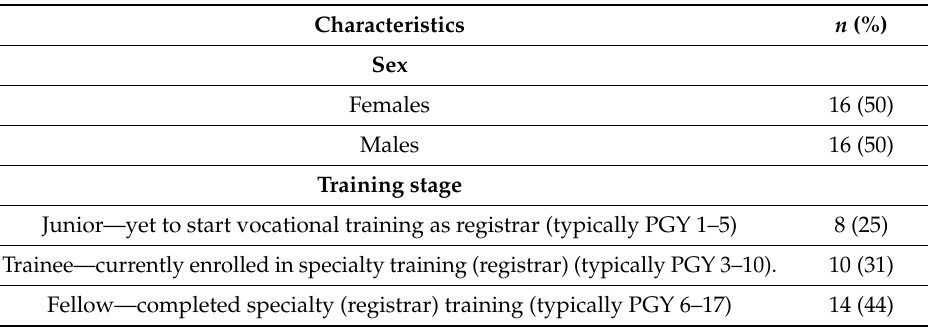
Table 3. Summary of phase 1 participants ( n = 32) a